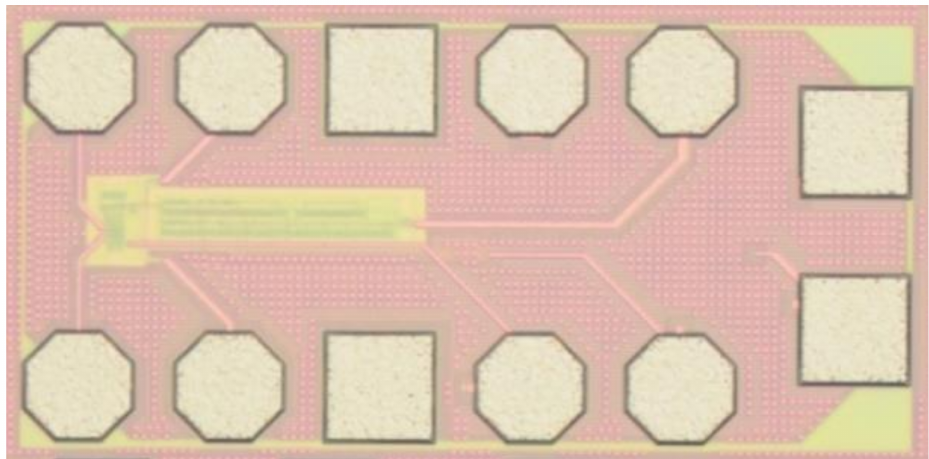
Figure 9. Chip microphotograph of the programmable frequency divider.